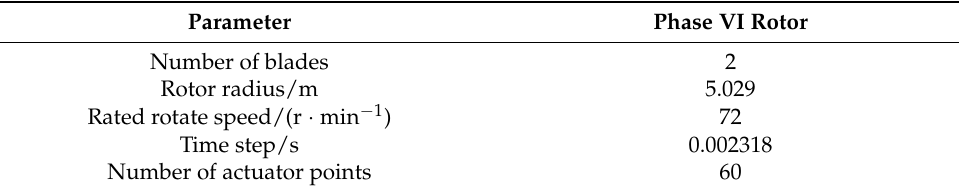
Table 1. Parameters of phase VI